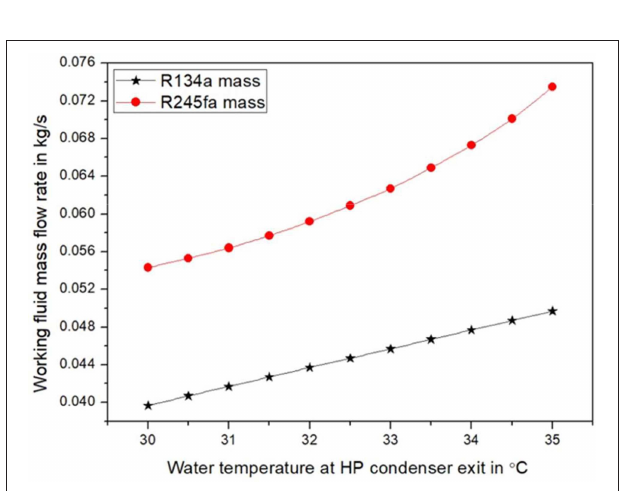
FIGURE 4 | The R134a and R245fa mass flow rates increase when T w − exit − HP